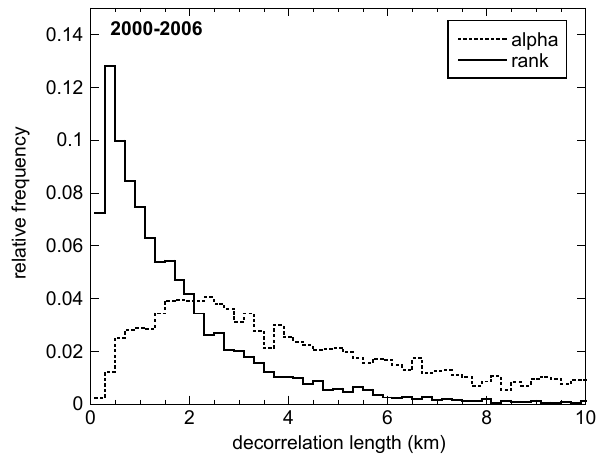
Fig. 4. Histograms of L α and L r derived from individual 150km segments. Due to the existence of a large fraction of L α val- ues greater than 10km (indicative of near-maximum overlap con- ditions), both histograms were renormalized with such values ex-